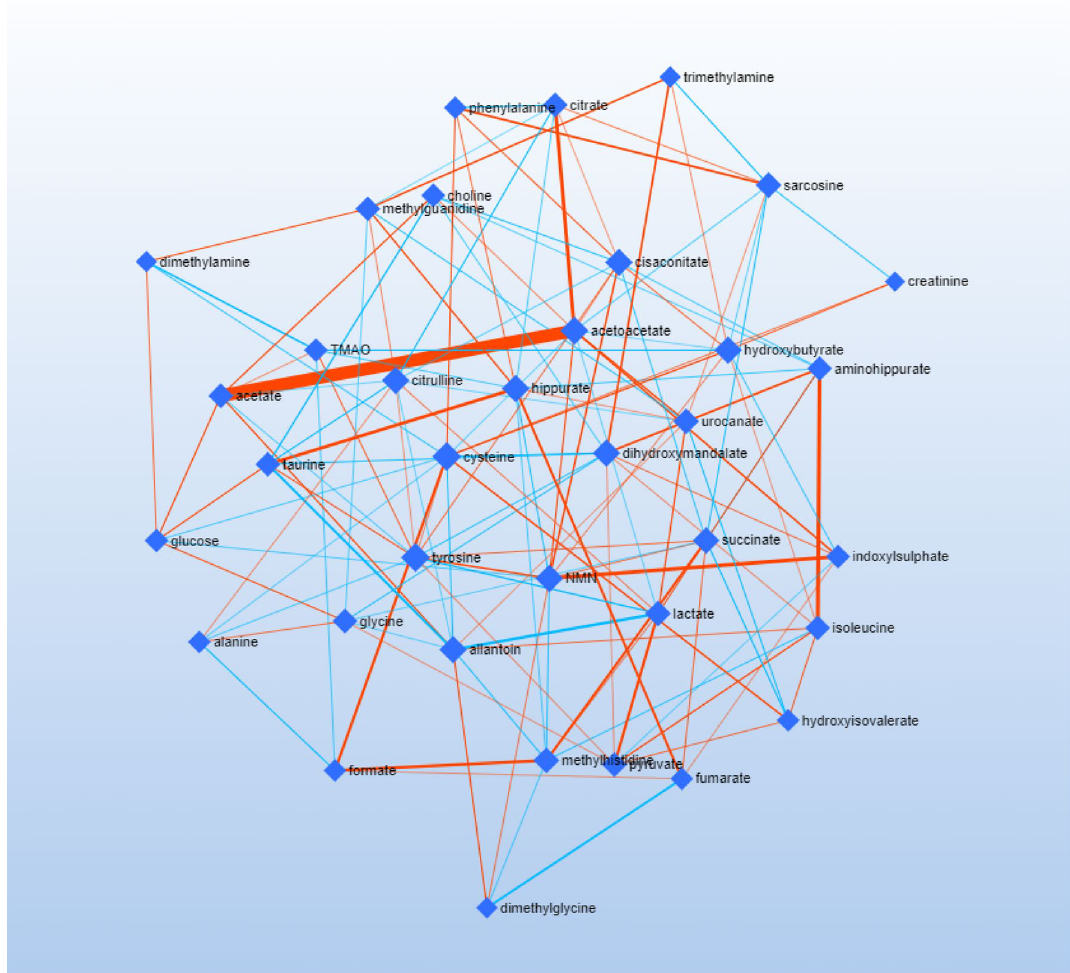
Figure 11. Debiased Sparse Partial Correlation Network Modelling (DSPC) indicating correlation between various metabolic